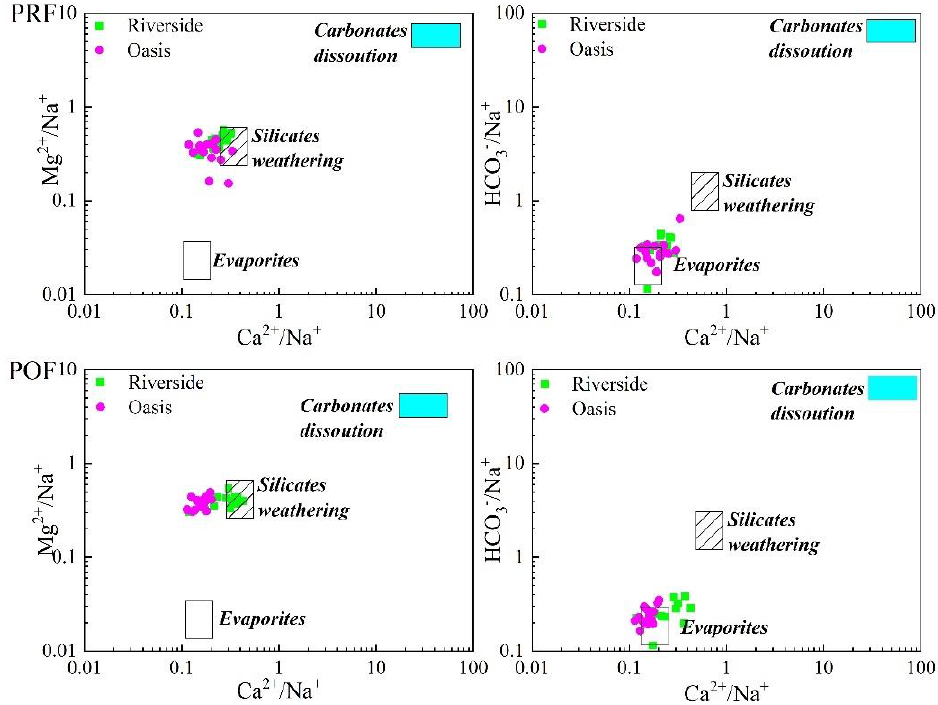
Figure 8. The ratio of Mg 2+ /Na + to Ca 2+ /Na + , and HCO 3 − /Na + to Ca 2+ /Na + in the groundwater of the study area.